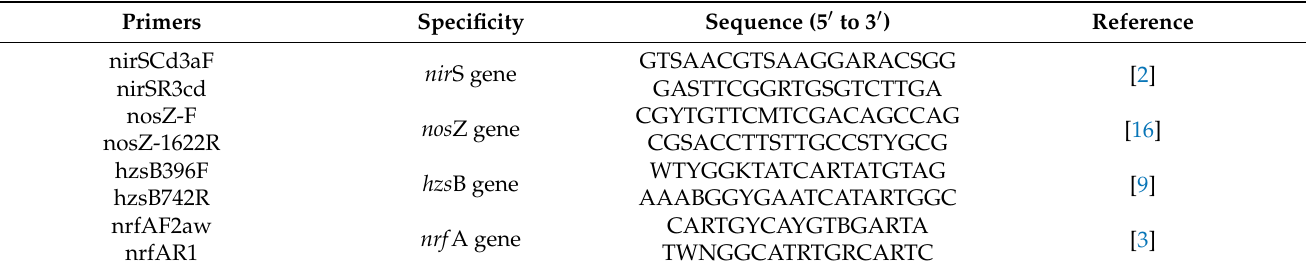
Table 1. Characteristics of primer and probe sets for real-time q-PCR. Primers Specificity Sequence (5 (cid:48) to 3 (cid:48)